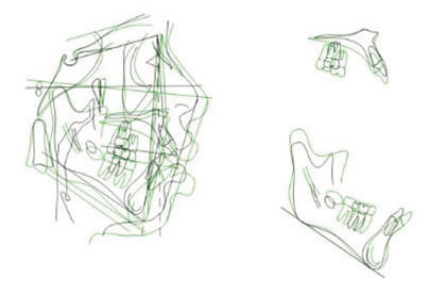
Figure 13: Stage 1: Orthodontic Treatment Superimposition.